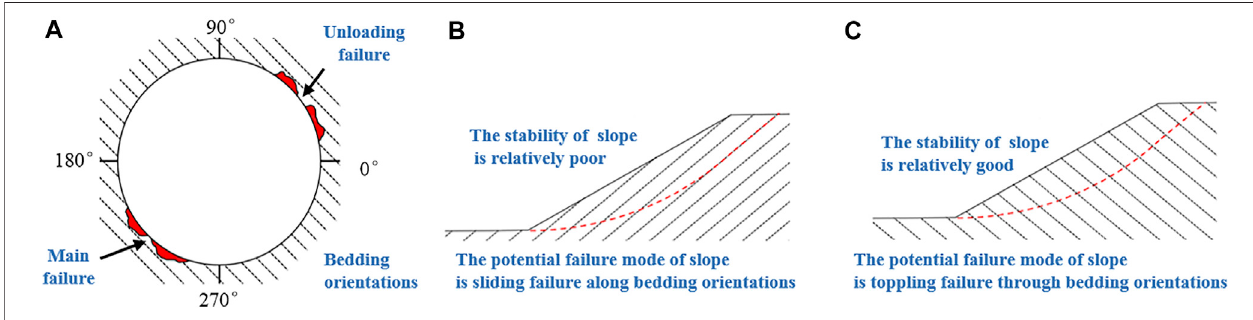
FIGURE 1 | In fl uence of the anisotropy of rock mass on the tunnel failure mode and the stability of slope. (A) Failure mode of the surrounding rock after tunnel excavation; (B) Stabilityanalysisofbeddedrock slopewithsmalldifferencebetweenslopeangleandbeddingorientation (C) Stability analysisofbeddedrockslopewith large difference between slope angle and bedding